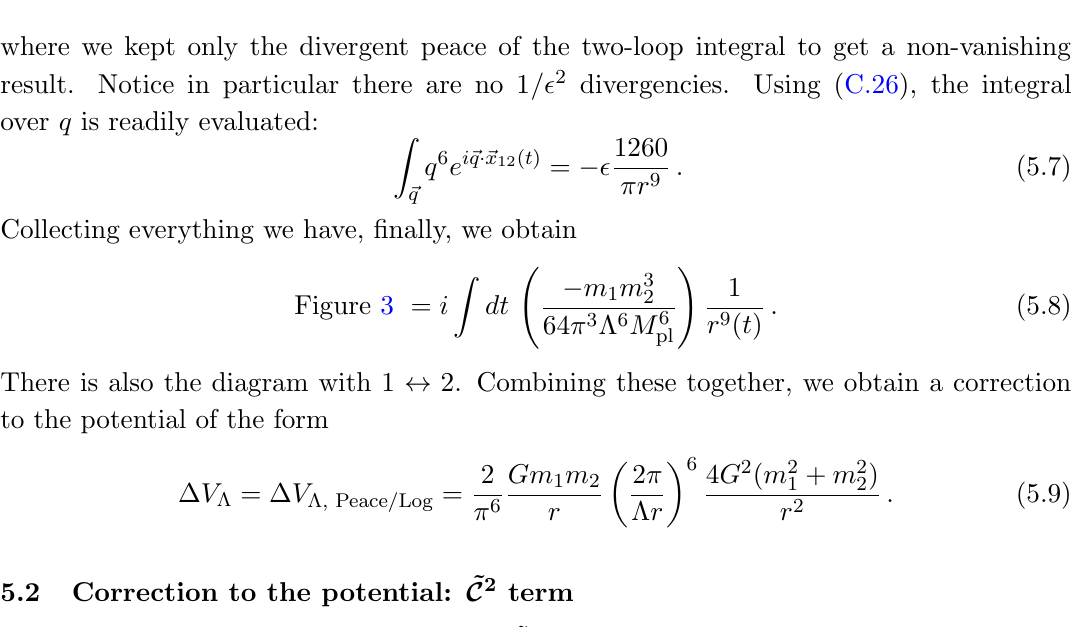
Figure 3 . The two loop diagram with the \peace/log"